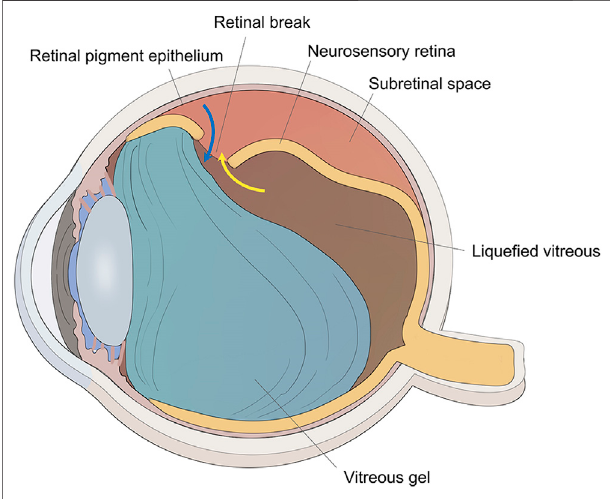
FIGURE 1 | The schematic diagram of RRD. The traction of vitreous gel onto the retina created the retinal break, and lique fi ed vitreous penetrated the subretinalspacethroughtheretinalbreaktoinduceretinaldetachment(yellow arrow).Retinalpigmentepithelialcellscouldmigratetothevitreouscavity through the retinal break (blue